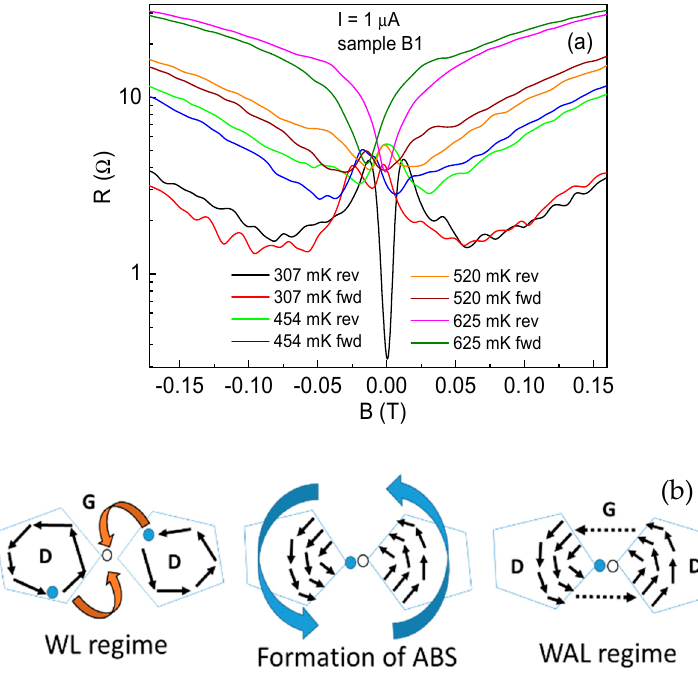
Figure 4. ( a ). Magnetoresistance of HBDDF changes the slope from a positive to a negative trend (at ~600 mK) as the sample temperature rises. ( b ) The left figure describes two WL paths of spin strictures (filled circles and small arrows) and the orbit − like ABS is formed by connecting the WL paths around a fixed point (open circles) that is not accessed by the spins. Effectively, this configuration can be formed by twisting a ring into another ring (large arrows). The middle figure represents an RSO configuration where the spin and orbits are mutually perpendicular to each other, which can also be described as two rings making interconnecting loops. This configuration can be described by a vortex structure with ABS at the core, as shown in the figure on the right. Here, D and G represent diamond grain and grain boundaries, respectively.